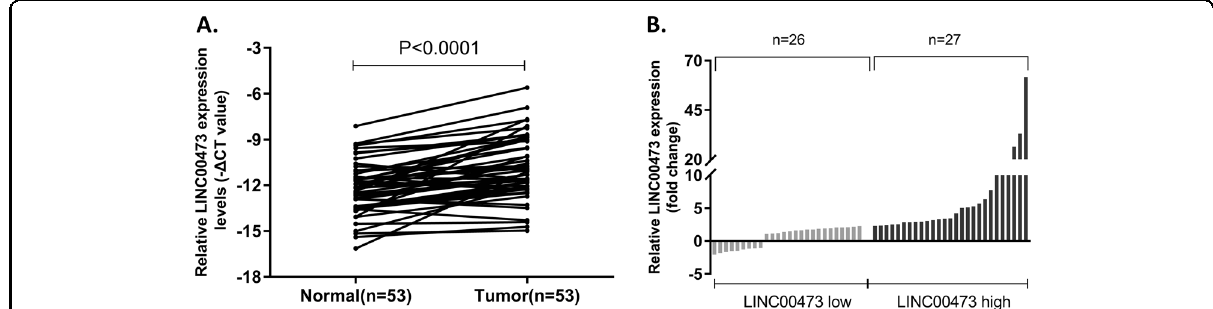
Fig. 1 Relative expression of LINC00473 in GC tissues. A Relative expression of LINC00473 in GC tissues ( n = 53) compared with the corresponding non-tumor tissues ( n = 53) was analyzed by qRT-PCR and normalized against GAPDH expression. The data were analyzed by the paired two-tailed t test ( P < 0.0001). B The GC patients were divided into two groups according to the expression of LINC00473. Error bars indicate mean ± standard deviation (SD). * P < 0.05, ** P < 0.01.